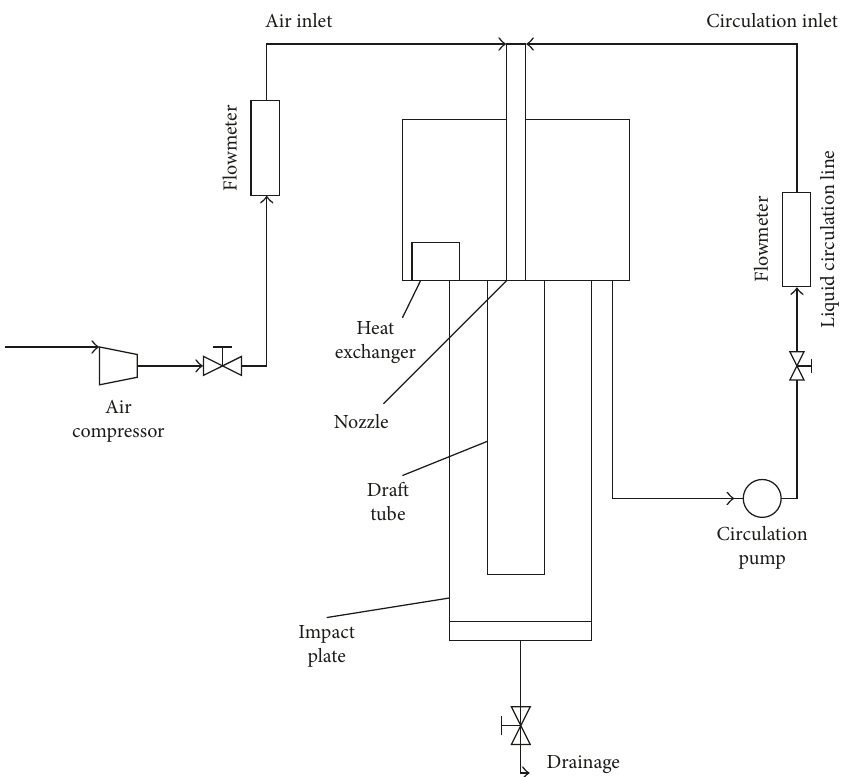
Figure 4: Schematic diagram of jet loop reactor